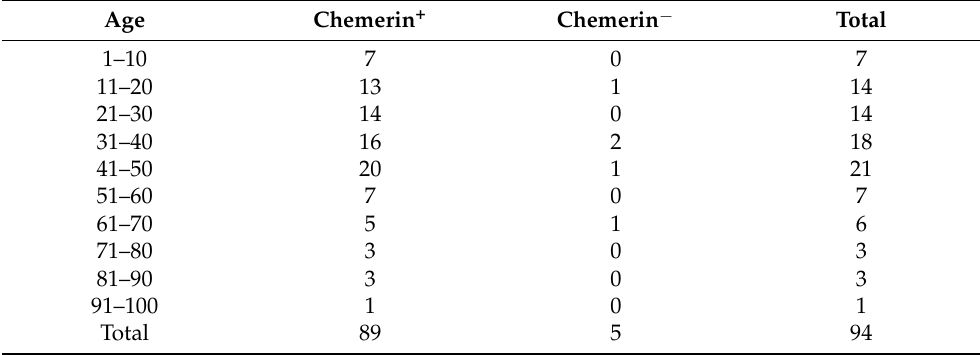
Table 4. Patients and chemerin status by age. p = 0.851 by Chi-squared test. Evaluated were only patients with readable